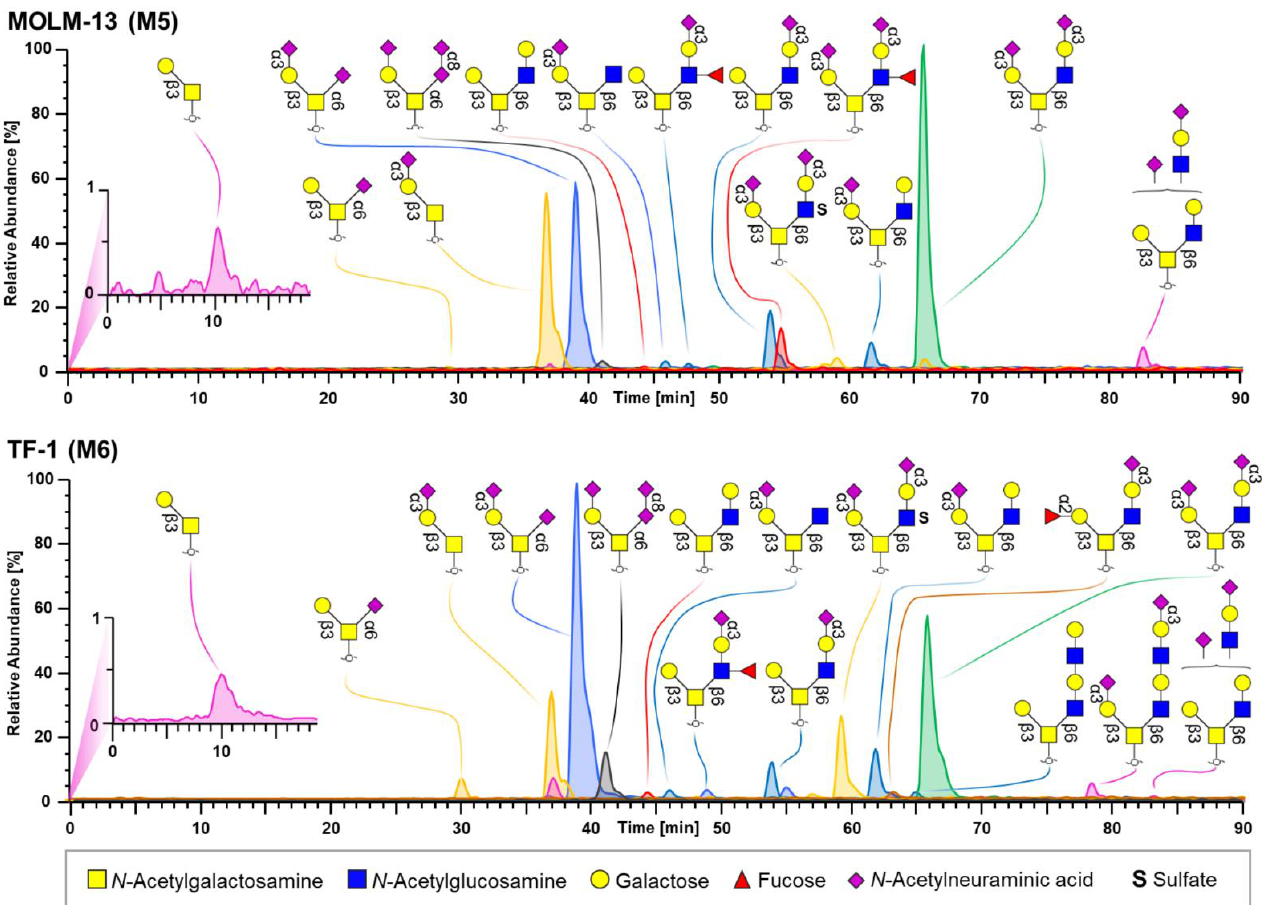
Figure 2. Exemplary combined EICCs of O -glycans obtained for the M5 subtype MOLM-13 ( upper panel ) and the M6 subtype TF-1 ( lower panel ). Individual mass traces are color coded. The symbols and colors of monosaccharides used for illustrating glycan structures are depicted beneath the panels. Identified glycosidic linkages are annotated.